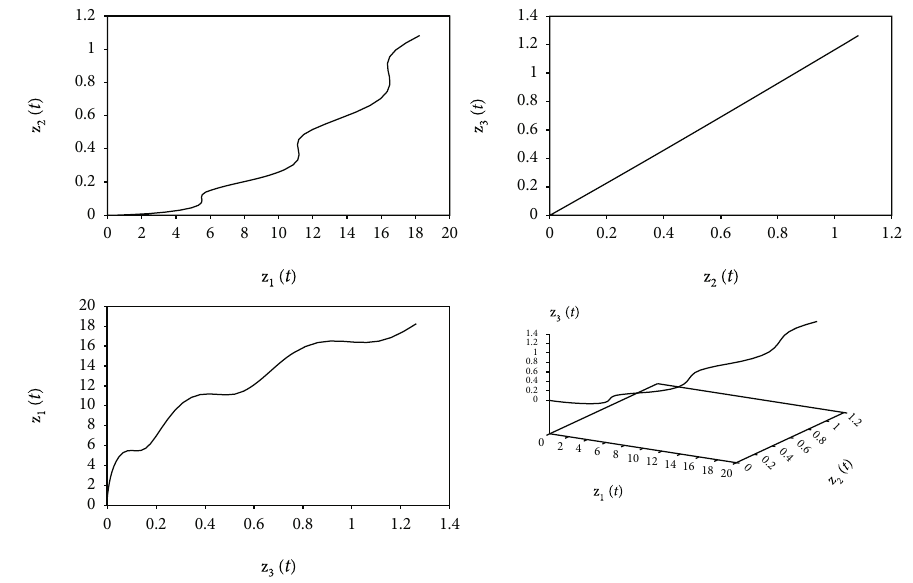
Figure 6: Phase portraits using 9-iteration NIM for sinusoidal